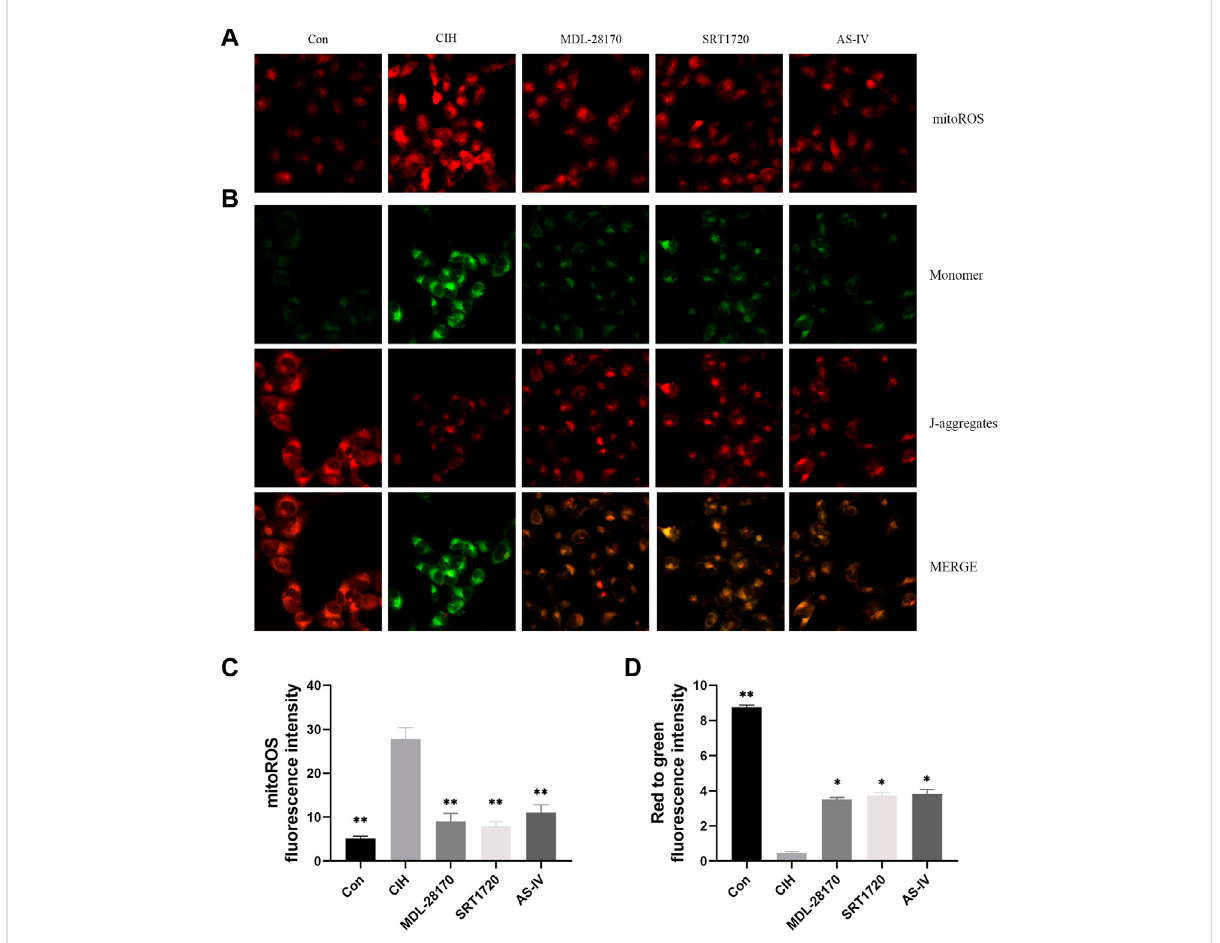
FIGURE 7 Effects ofAs-IV,MDL-28170 and SRT1720 on mitochondrial dysfunction inHCAECs exposedto CIH. (A,C) Representative fl uorescence images and fl uorescence intensity of mitoROS in HCAECs of different groups (×200 magni fi cation; n = 3). MitoSOX dye (red). (B,D) Representative fl uorescence images of JC-1 staining indicating the mitochondrial membrane potential in HCAECs of different groups (×200 magni fi cation; n = 3). Monomer (green), J-aggregates (red). Data are presented as means ± SD. ** p < 0.01, *P ＜ 0.05, vs. CIH